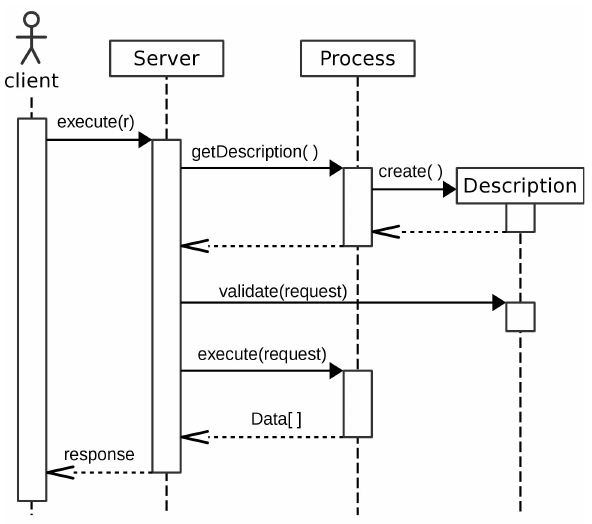
Figure 4. Sequence diagram representing an Execute